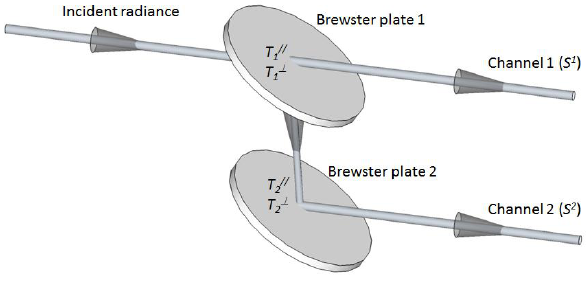
Figure 1: Schematic representation of the co-polar and cross-polar channels. 571 Fig. 1. Schematic representation of the co-polar and cross-polar channels.